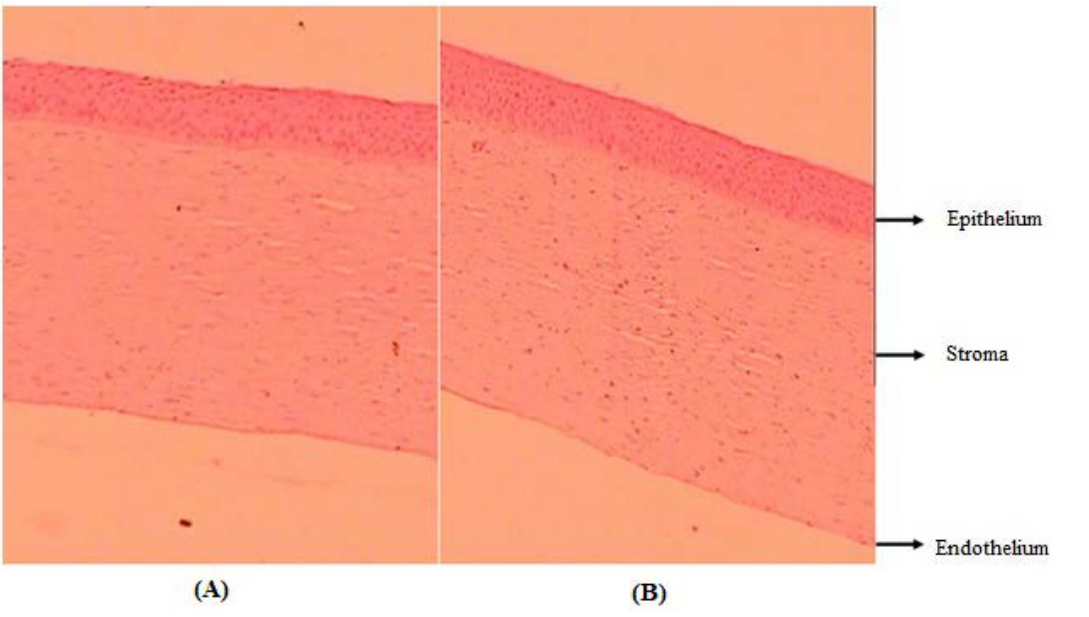
Figure 6. Histology image of treated goat cornea with ( A ) 0.9% w / v NaCl and ( B ) CIP-BLO-opt-IG3 (10 × 10 × magnification). No changes were found in the corneal structure after treatment, revealing no irritation.